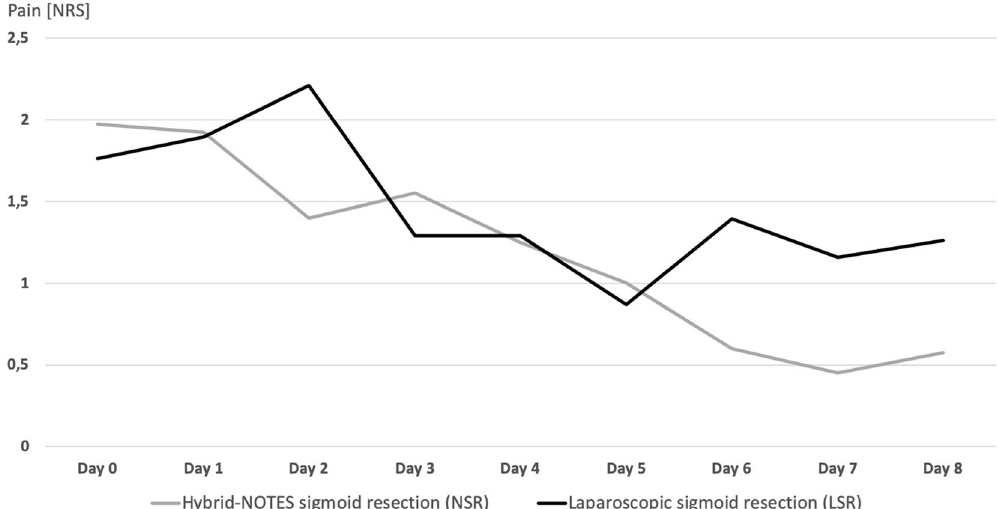
Figure 3. Pain intensity over time.